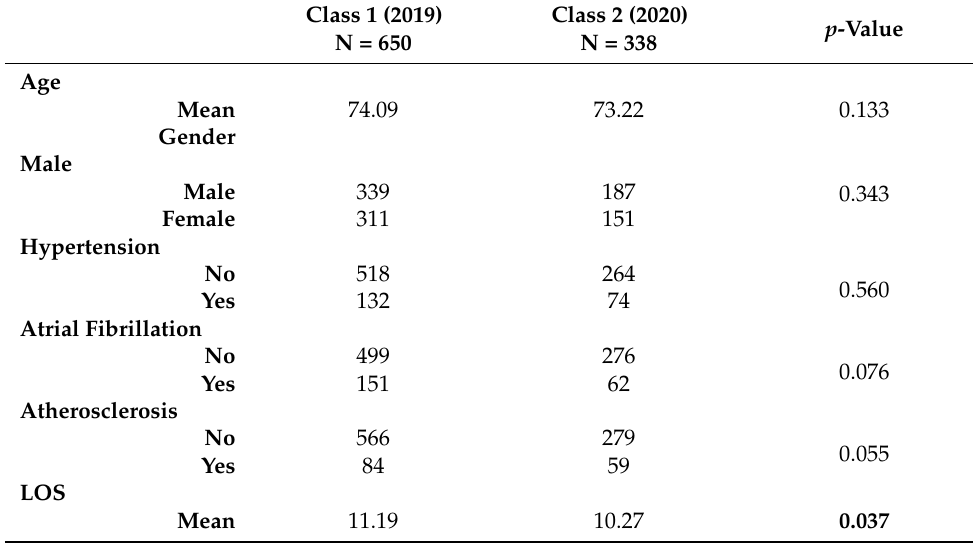
Table 8. Statistics analysis — Stroke patients.